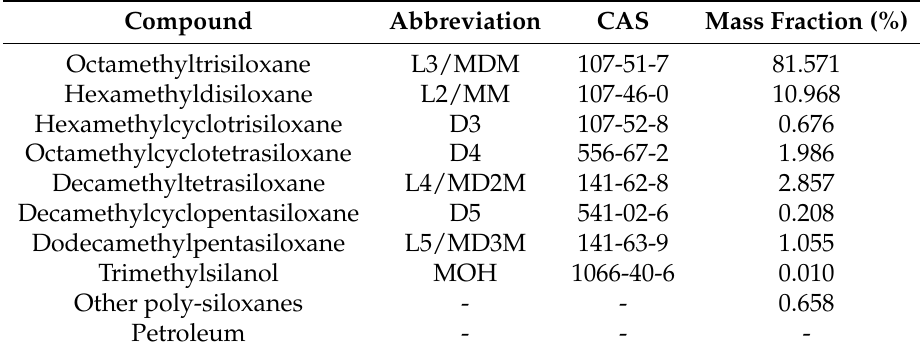
Table A3. HS-GC-MS analysis results of Experiment A,